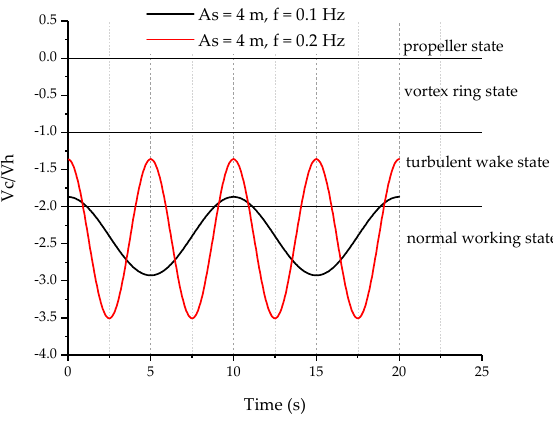
Figure 11. VRS identification scheme under surge motion.